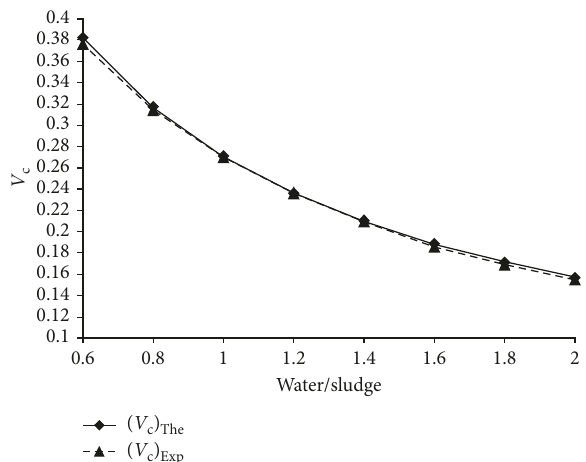
Figure 6: Experimental and theoretical volume concentrations of the solid and water/sludge ratio relationship.